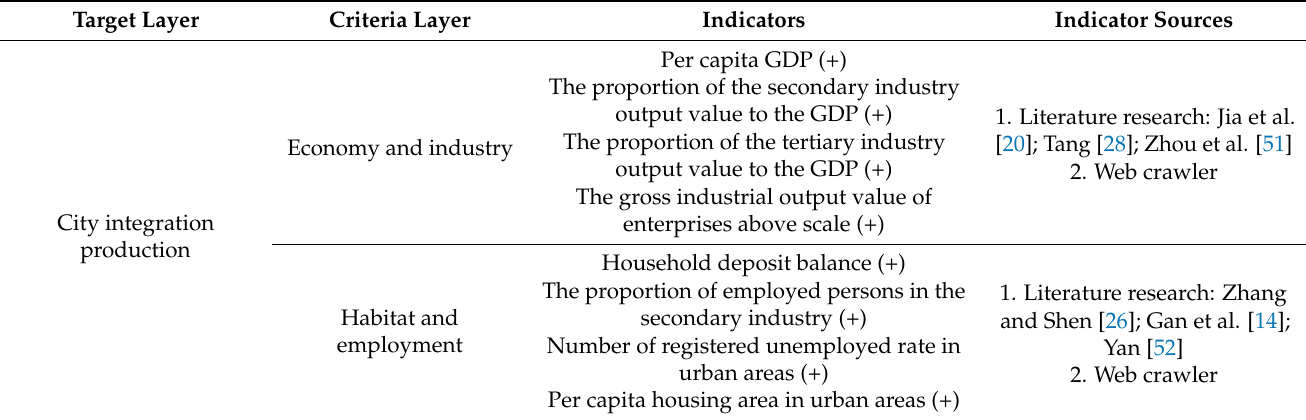
Figure 2. Selenium WebDriver controlling Chrome. Table 2. Indicators sources of the index